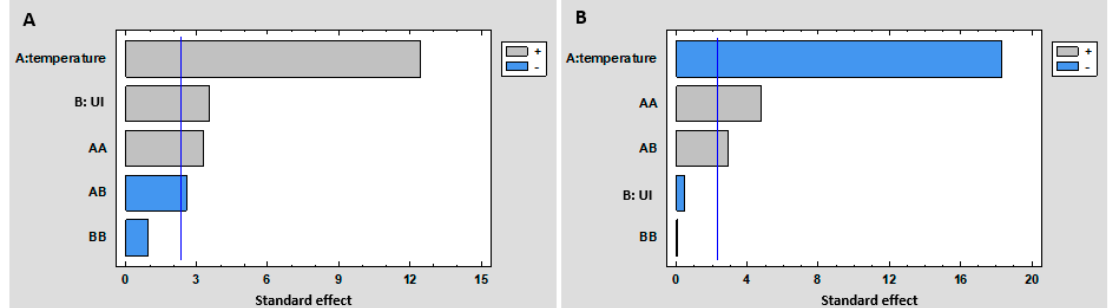
Figure 2. ( A ) Pareto graphic for TPC; ( B ) Pareto graphic SST.